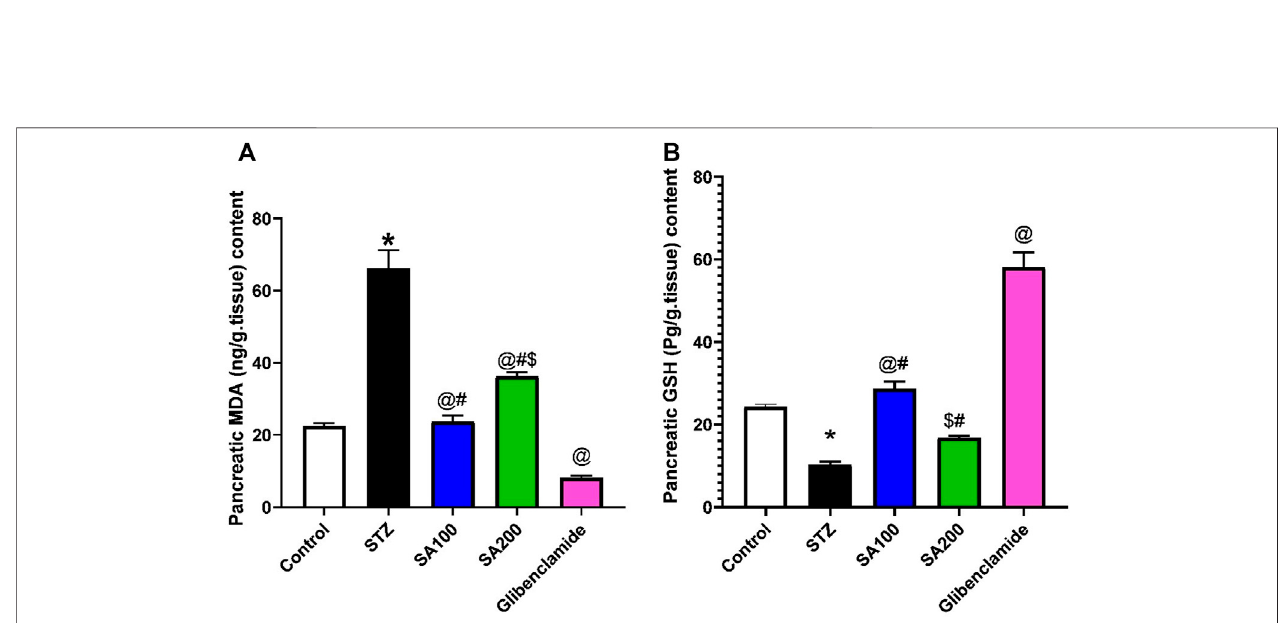
FIGURE 5 | Results from the oral administration of the leaf extract of S. aqueum (SA) on the levels of pancreatic (A) malondialdehyde (MDA) and (B) reduced glutathione (GSH) in STZ diabetic animals. Results are presented as mean ± SEM. *Signi fi cant difference related to the normal control group, @ related to STZ diabetic rats, # related to reference drug group, glibenclamide, and $ related to SA100 at p < 0.05 by One-Way ANOVA and Tukey post hoc test, n (cid:2) 6.